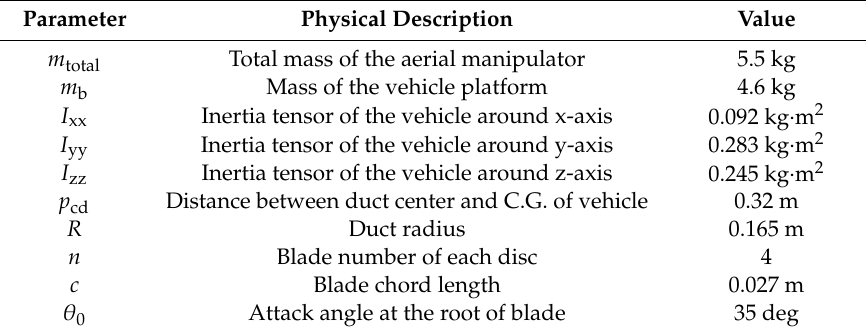
Figure 1. The configuration and coordinate frame of the system. Table 1. Structural parameters of the aerial manipulator.